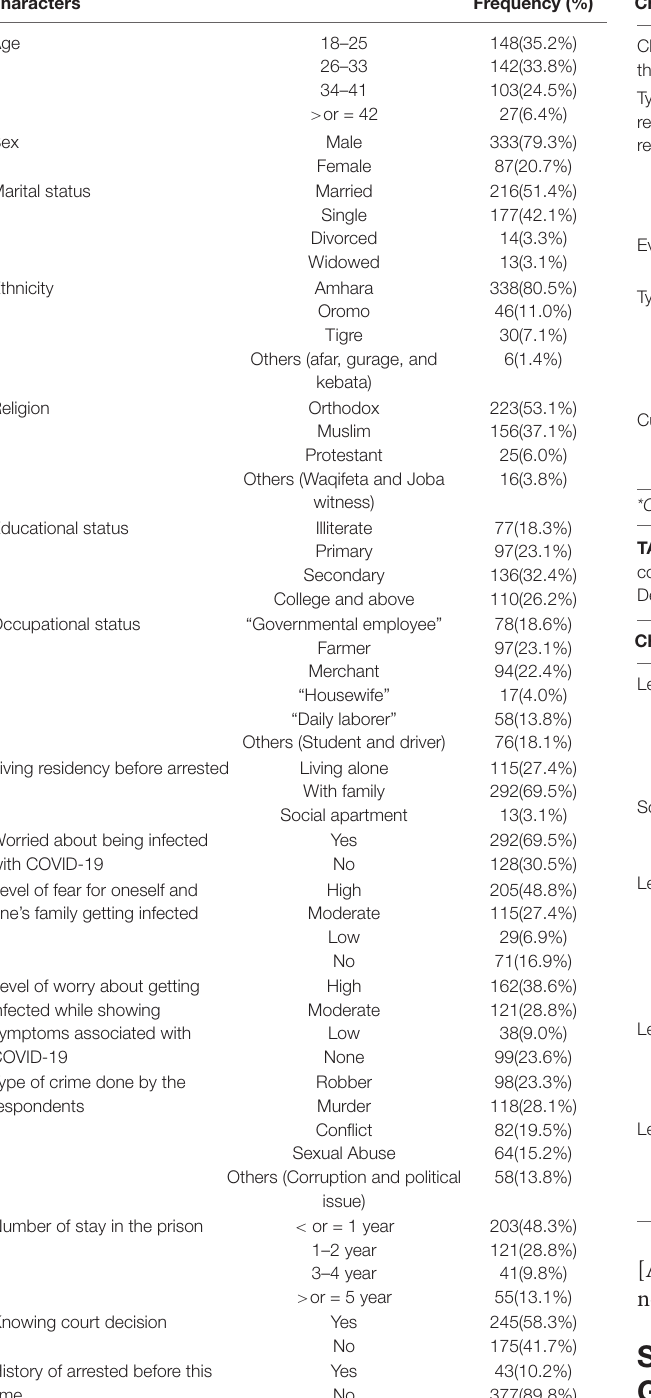
TABLE 2 | History of Chronic illness and substance use behavior during COVID-19 pandemic of study participants among Dessie town prisoners in Dessie